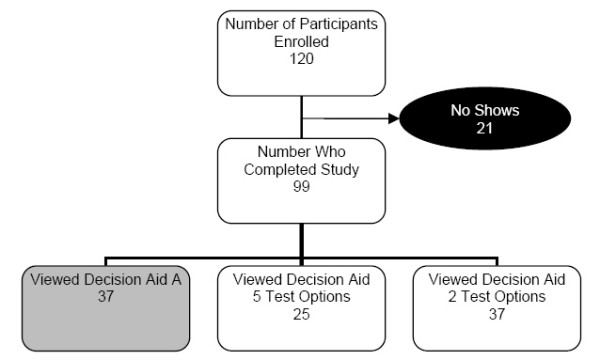
Study Randomization.